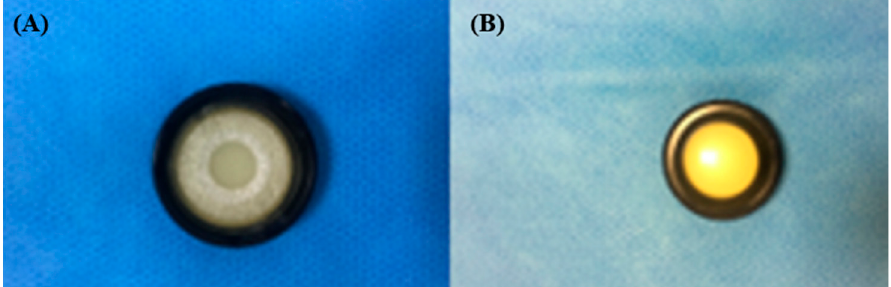
Figure 3. Sham adapter: (A) inside view; (B) outside view.